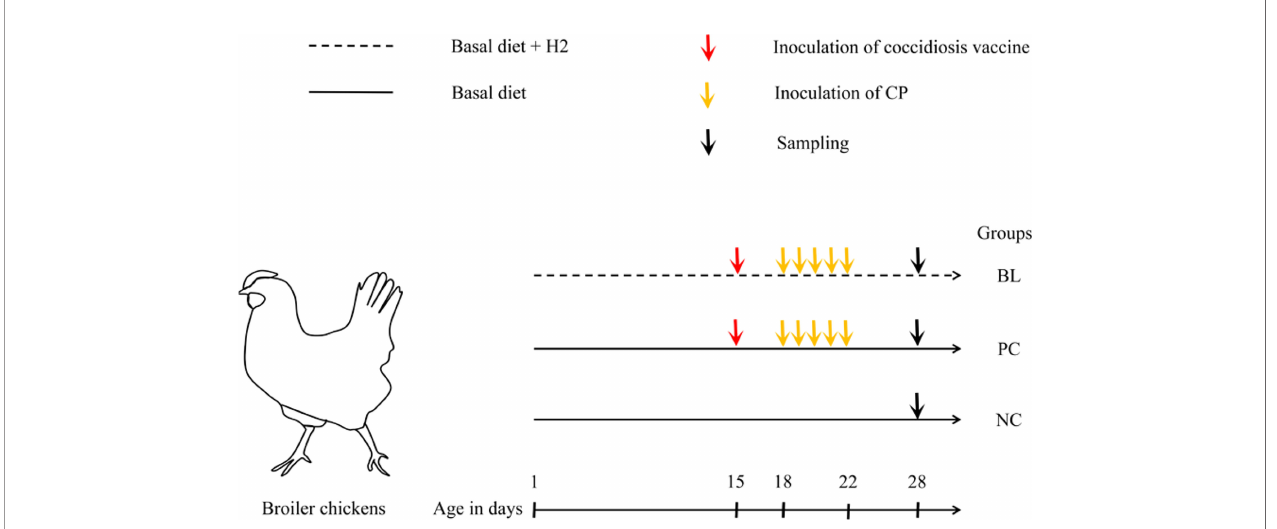
FIGURE 1 | Sketch of animal experiment design. Newly hatched chicks with similar birth weights were randomly allocated to three groups with different treatments. NC, birds received basal diet supplemented with LB liquid medium; PC, birds received basal diet and induction of SNE; BL, birds received induction of SNE and basal diet supplemented with 1.0 × 10 6 cfu B licheniformis H2/g